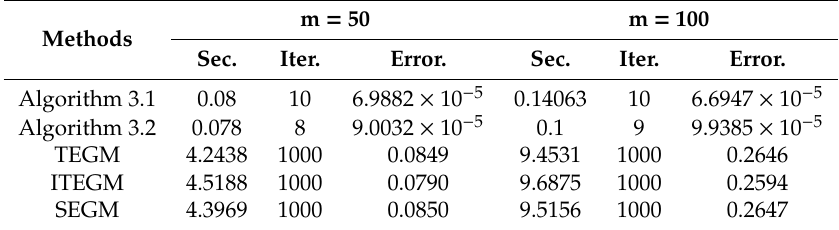
Algorithm 3.1 Algorithm 3.2